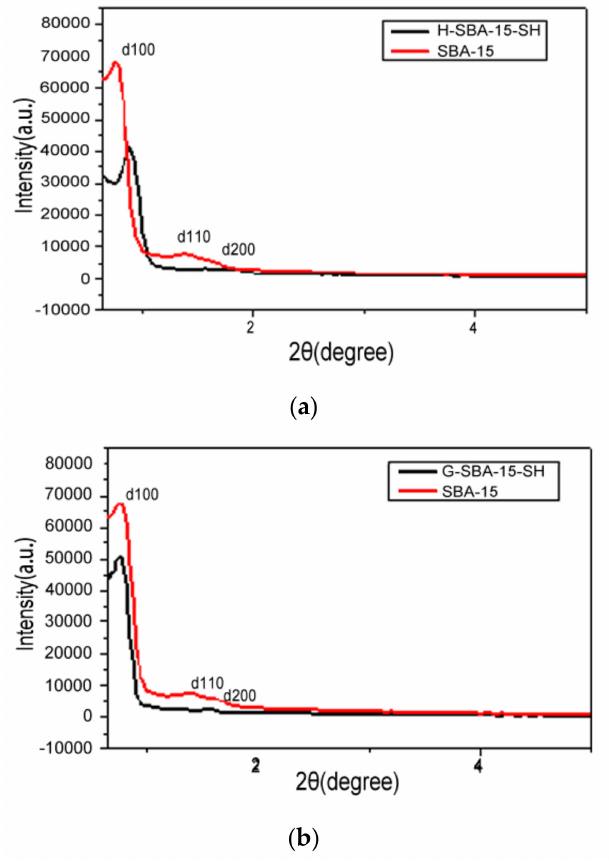
Figure 1. ( a ) X-ray diffraction patterns of mesoporous SBA-15 and H-SBA-15-SH; ( b ) X-ray diffraction patterns of mesoporous SBA-15 and